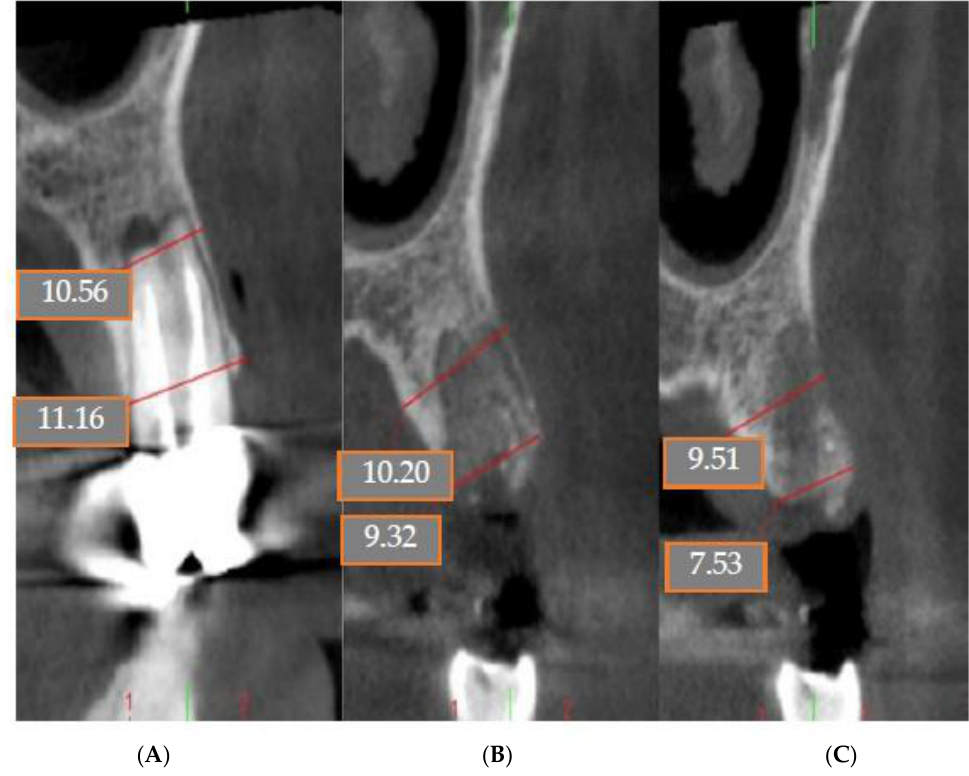
Figure 10. ( A ) Previous CBCT; ( B ) Immediate postoperative CBCT; ( C ) Postoperative CBCT after 4 months.